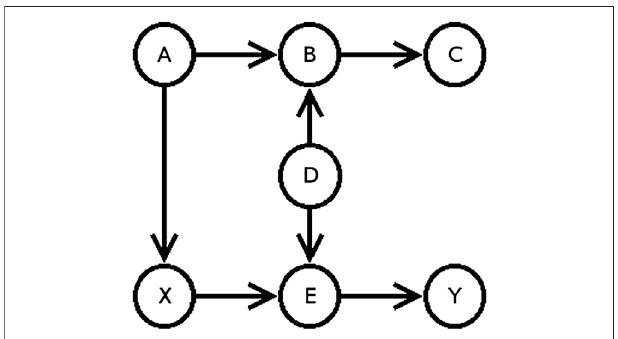
FIGURE 1 | A simple causal model following the de fi nitions of (Pearl and Mackenzie, 2018, 159) (created by the